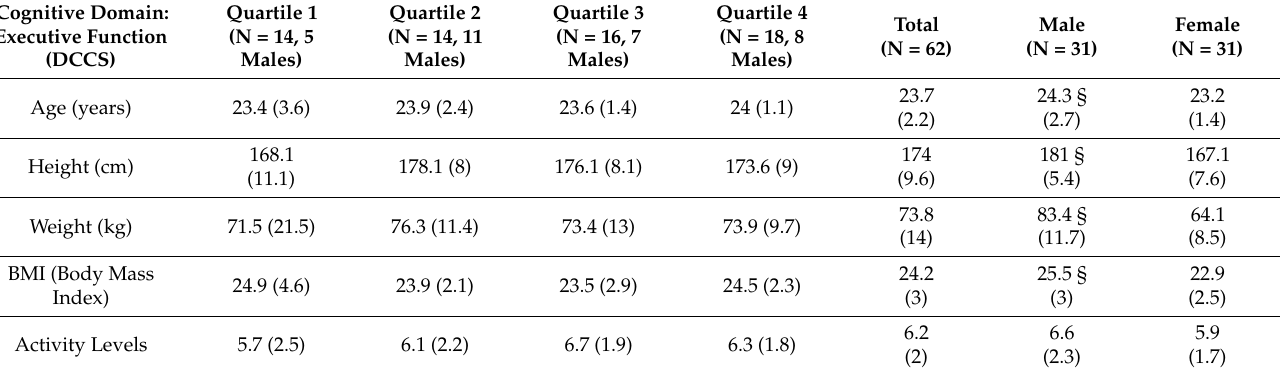
Table 2. Average (sd) age, height, weight, body mass index, activity levels, heart rate (HR), standard deviation of N–N interval (SDNN), low-frequency to high-frequency ratio (LF/HF), and DCCS testing score shown for quartiles, total, males, and females. * = p < 0.05 for comparison between lower 50% and upper 50% of quartile, §: p < 0.05 of a comparison between males and